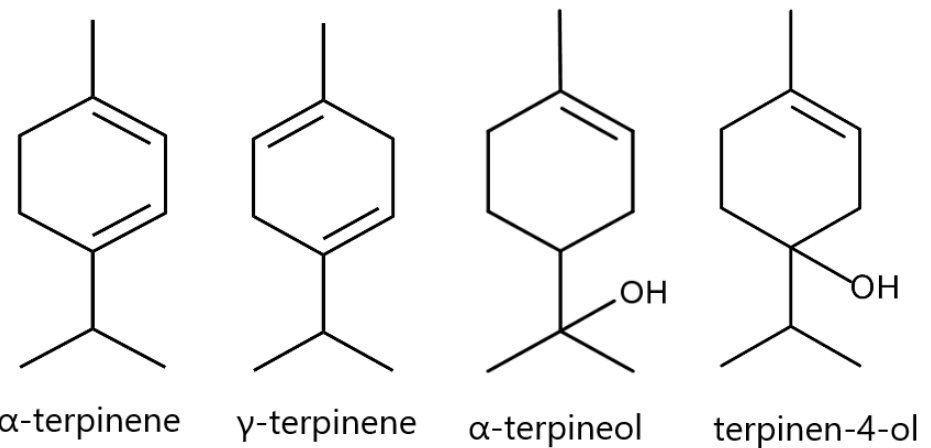
Figure 2. Chemical structures of the major phytoconstituents determined in TTO via GC/MS analysis. The mass spectrum of terpinen-4-ol is shown in comparison with a substance from